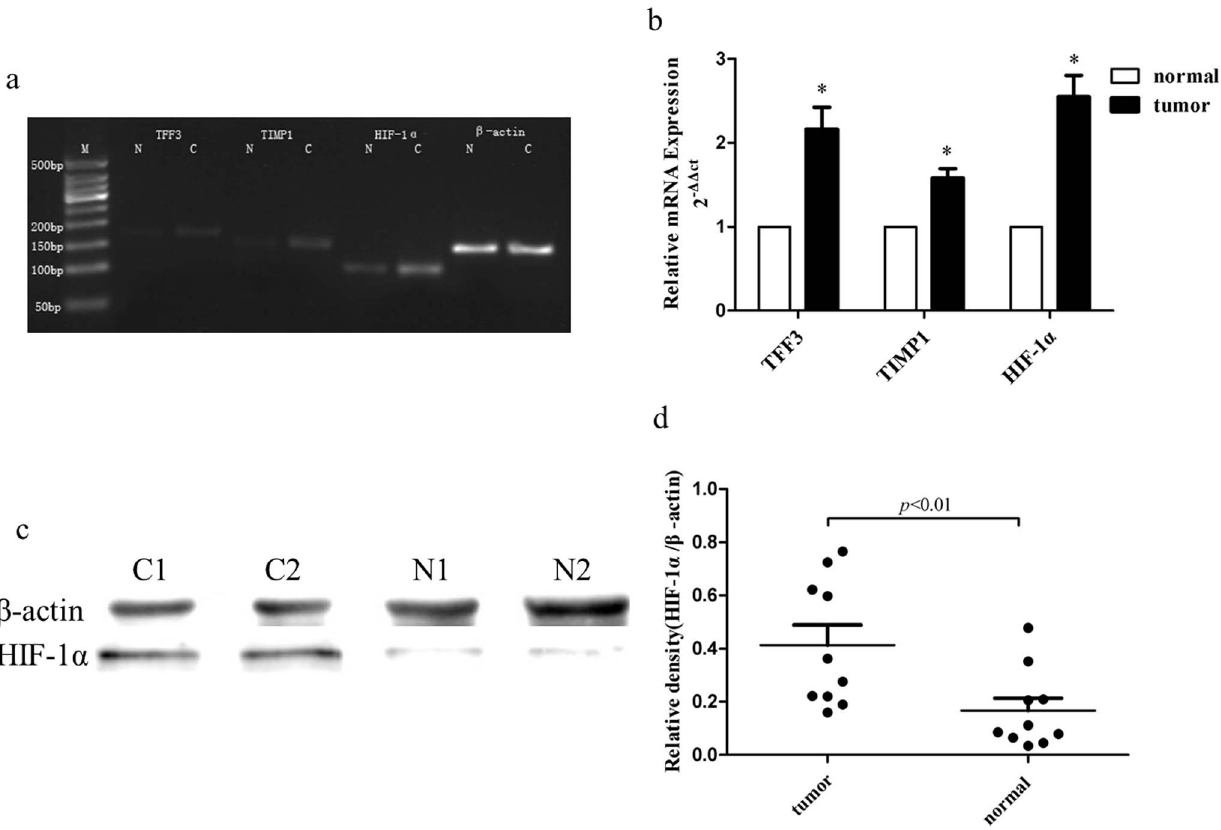
Figure 1. Validation of overexpression of HIF-1 a , TIMP1 and TFF3 in 10 pairs of gastric cancer vs. normal tissues. a and b, Detection of HIF-1 a , TIMP1 and TFF3 mRNA expression in gastric cancer vs. normal tissues using PCR and qRT-PCR. Levels of HIF-1 a , TIMP1, TFF3 mRNA were 2.55 6 0.56, 1.58 6 0.25, 2.16 6 0.59 folds up-regulated in tumor tissues, respectively compared to those of the normal ones. *p , 0.01. c and d, Western blot analysis of HIF-1 a protein. Tumor tissues expressed higher level of HIF-1 a protein compared to the normal ones [p , 0.01 (d). N, normal tissues; C, cancer tissues (c)].